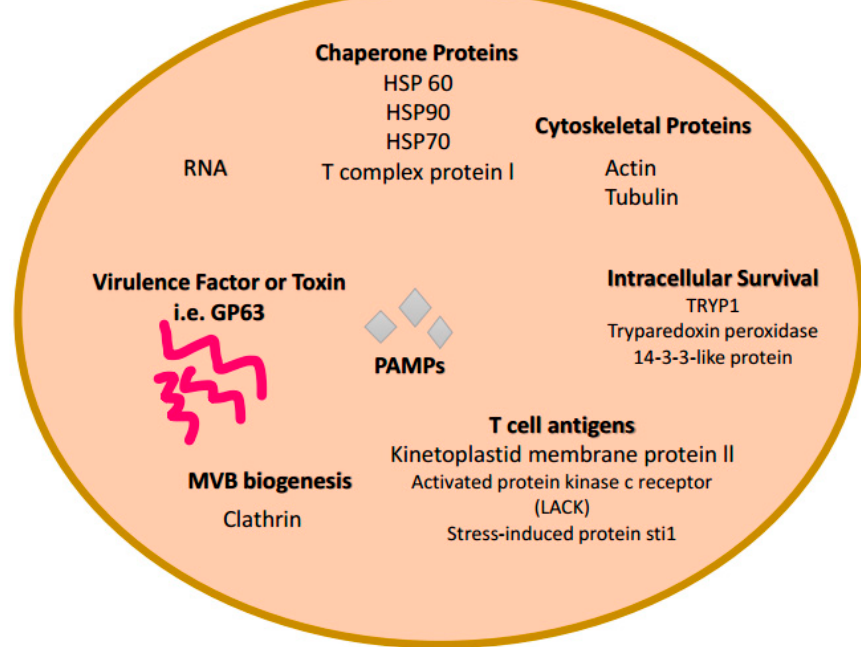
Figure 3. Composition of protozoa-derived exosomes. Proteomic, Biochemical, and Immunological investigations have identified many specific proteins and RNAs present in some exosomes. This is a limited representation of common molecules present within some protozoa-derived exosomes. Molecules illustrated here are grouped based on category function or protein class: Chaperone proteins, Cytoskeletal proteins, Toxins or virulence factors, MVB biogenesis proteins, and RNAs. Some of these molecules are also found in bacteria derived-exosomes (Figure 2) and mammalian derived-exosomes (Figure 1).